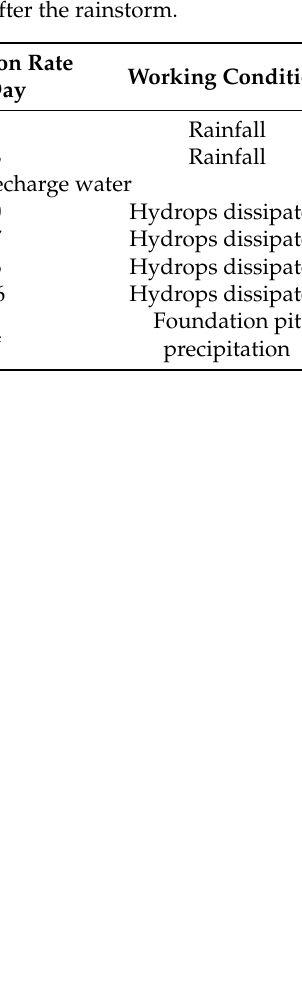
Figure 2. Disaster scene map of Xiaonangang Station.